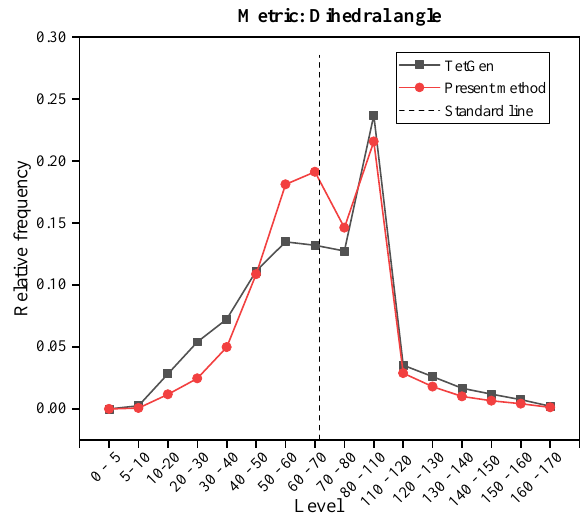
Figure 12. Statistics of the mesh quality of dihedral angle for final geological